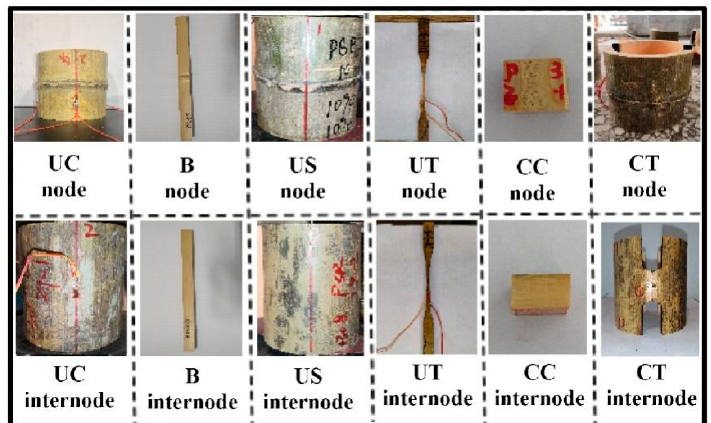
Figure 1. The specimen considering the effect of bamboo nodes.